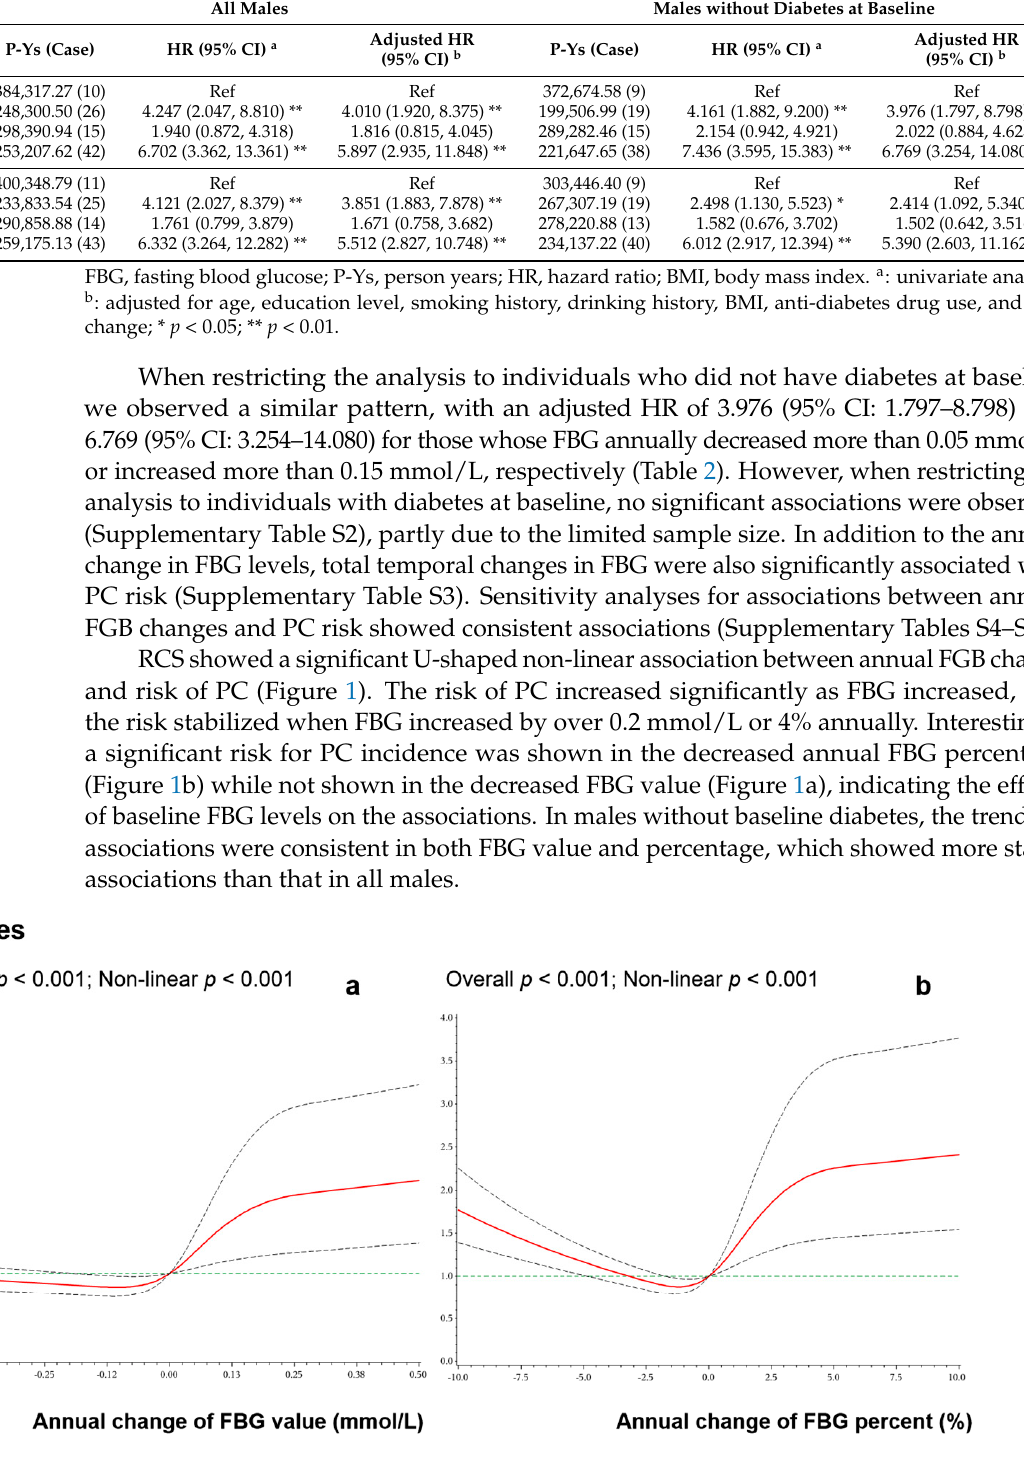
Figure 1. Non-linear associations between annual FBG change and the risk of PC. ( a ) Annual change in FBG value in all males, ( b ) annual change in FBG percent in all males, ( c ) annual change in FBG value in males without diabetes at baseline, and ( d ) annual change in FBG percent in males without diabetes at baseline. 3.4. FBG Stability Participants with at least two FBG measurements were included in the analysis of FBG stability. The Cox regression analysis showed that a higher CV and greater range of FBG levels during a period were associated with an increased risk of PC (Table 3). When setting an FBG CV of less than 5% as the reference, the group with a CV between 5% and 15% and that with a CV over 15% had approximately six-fold and eight-fold increased risks of PC, respectively, and the HRs in all males and in males without diabetes at baseline were almost the same. The linear Cox regression analysis also showed significant associations, with a 2.5% risk increase in all men (HR, 1.025; 95% CI: 1.009–1.042) and a 2.9% risk increase in men without diabetes at baseline (HR, 1.029; 95% CI: 1.011–1.049) with each 1% increase in CV. When setting an FBG range of less than 0.5 mmol/L as the reference, individuals with a range between 0.5 and 1.5 mmol/L and with over 1.5 mmol/L had more than two-fold and three-fold increased risks of PC, respectively, both in all males and in males without diabetes at baseline. A 7.3% increase in the risk of PC was observed in all men (HR, 1.073; 95% CI: 1.021–1.128) and an 8.4% increase in risk of PC was observed in men without diabetes at baseline (HR, 1.084; 95% CI: 1.016–1.157) for every 0.56 mmol/L increase in the range. No significant association was observed between